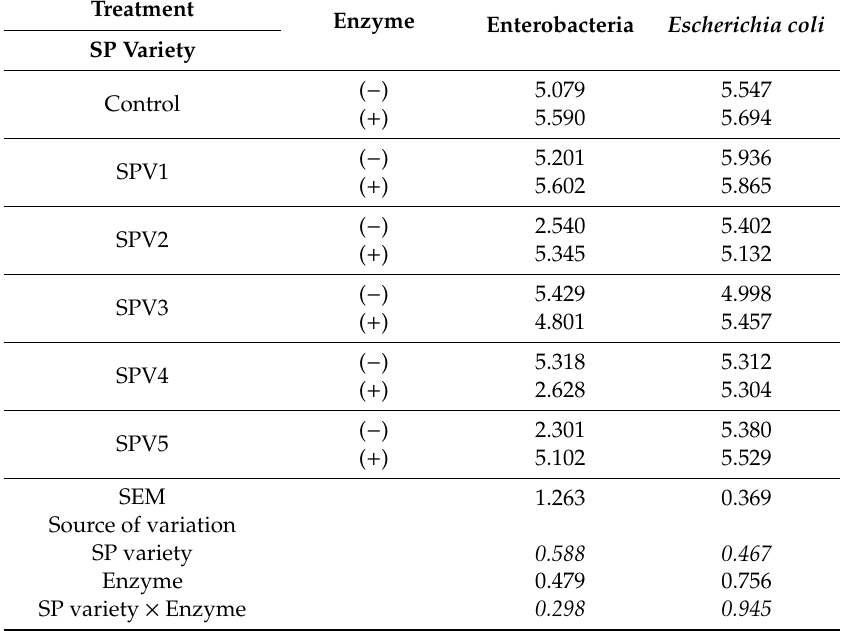
Table 4. Counts of total Enterobacteriaceae and E.coli (Log CFU / g / mL) in chickens fed di ff erent sweetpotato